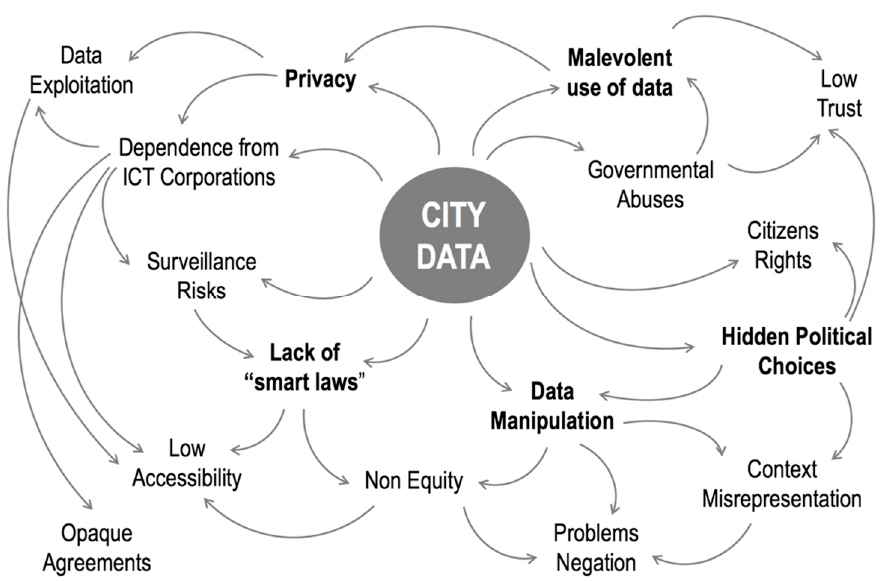
Figure 1. Map of the key issues associated to city data and their governance in the smart city literature (source: author’s elaboration).